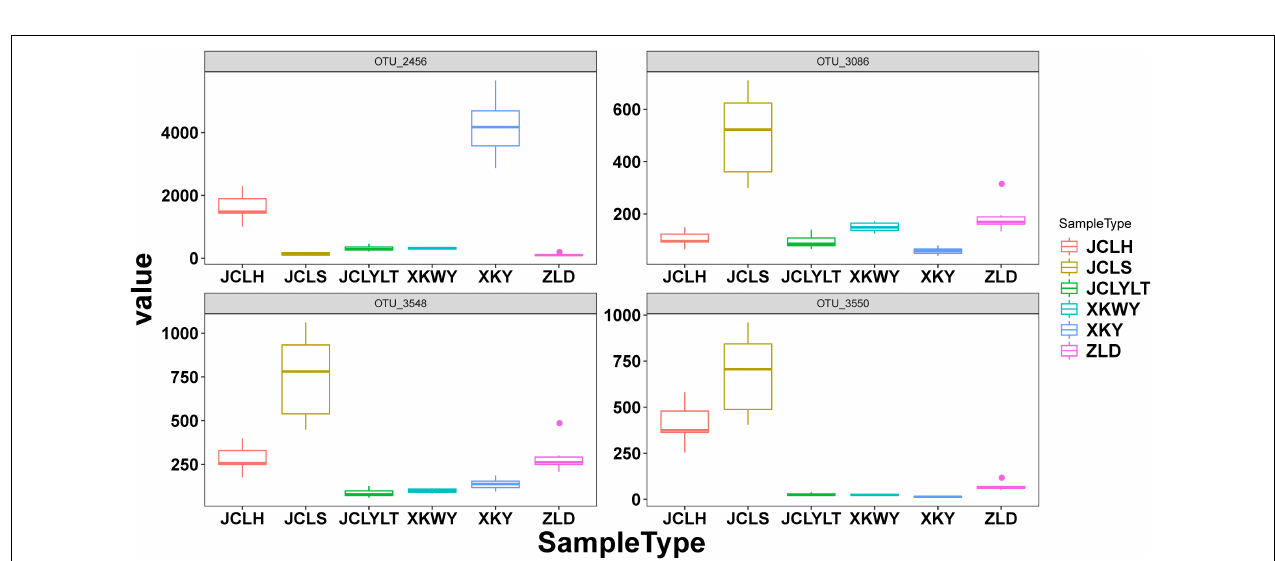
FIGURE 6 | The relative abundance of OTUs 2456, OTUs 3086, OTUs 3548, and OTUs 3550 in the studied soils.